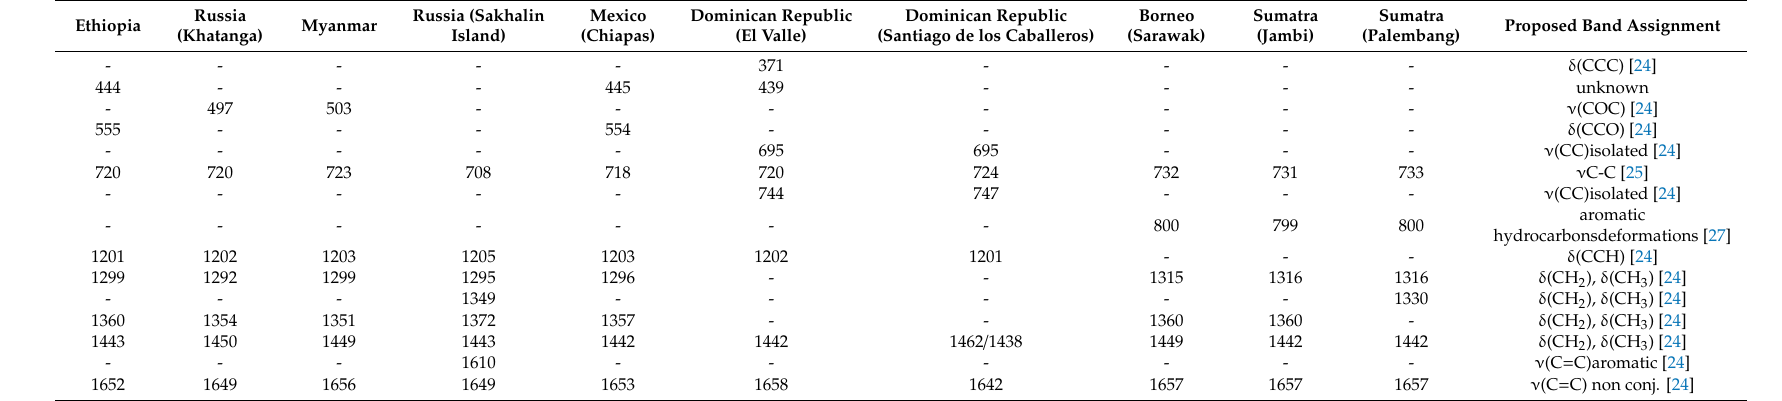
Table 2. NIR-Raman bands (cm − 1 ) for the analysed resins and their tentative